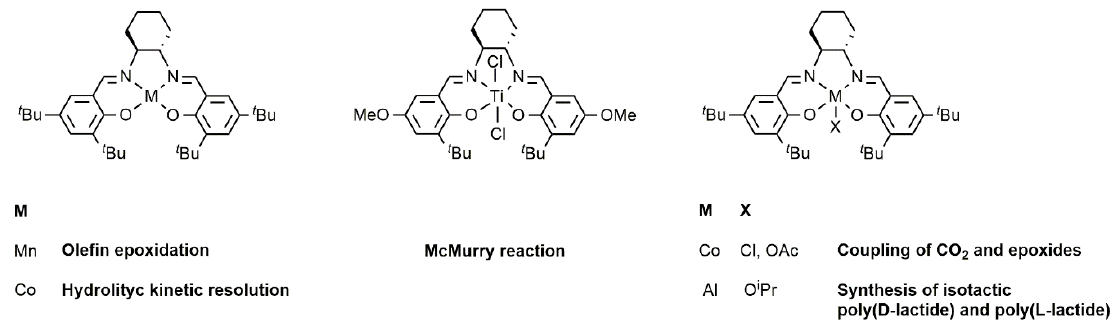
Figure 3. Selected examples of metal complexes containing a chiral Salen ligand and their applications [38].